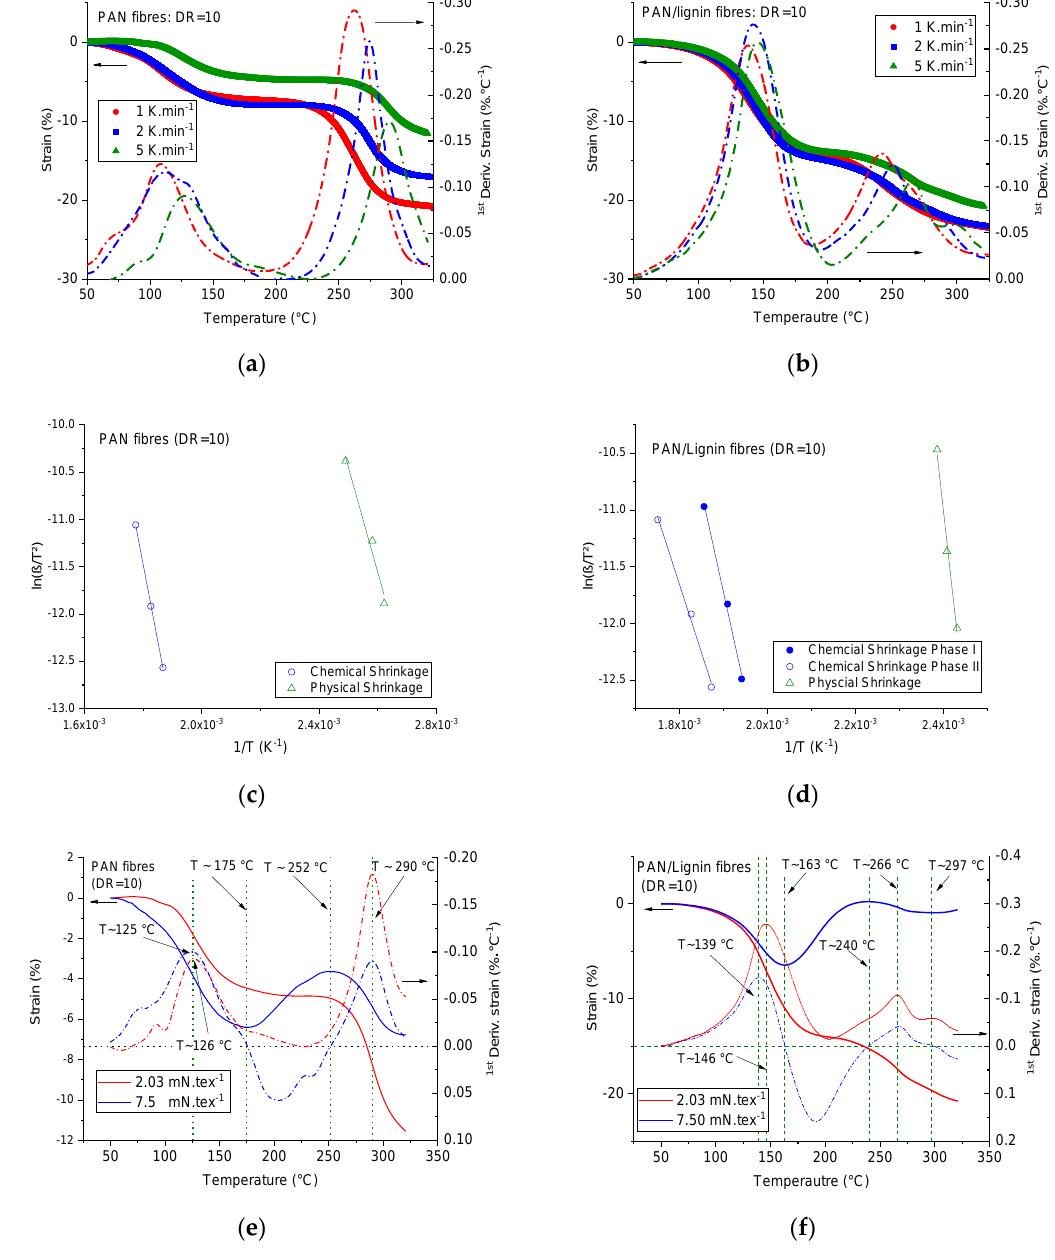
Figure 9. Plot of the strain and first derivative of the strain versus the temperature of ( a ) neat PAN fibers at DR = 10 and ( b ) PAN/lignin fibers at DR = 10 at a specific constant load of 2.03 mN·tex −1 ; Kissinger plot of the physical and chemical shrinkage of ( c ) neat PAN fibers and ( d ) PAN/lignin fibers; impact of the specific pre-tension on the shrinkage behavior of ( e ) PAN fibers (DR = 10) and ( f ) PAN/lignin fibers (DR = 10) recorded at 5 K min −1 under air.